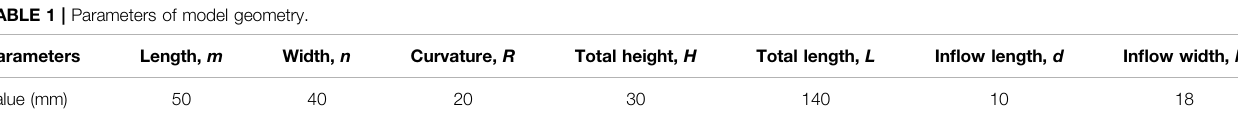
TABLE 1 | Parameters of model geometry.